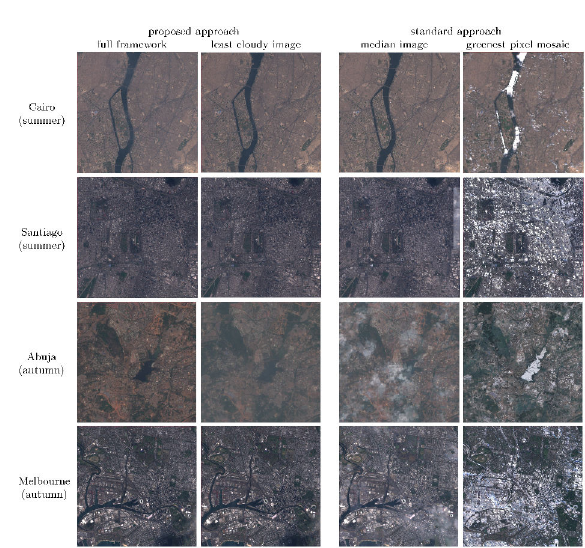
Figure 8. Cloud-free image aggregation examples for areas rarely affected by clouds.